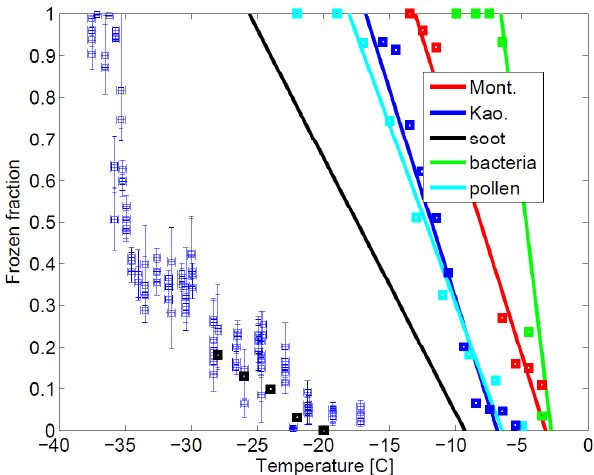
Fig. 16. Comparison of contact freezing frozen fractions obtained from wind tunnel studies (thick squares) using kaolinite (blue) and montmorillonite (red) (Pitter and Pruppacher, 1973), soot (black) (Diehl and Mitra, 1998), pollen (light blue) (Diehl et al., 2002) and bacteria (green) (Levin and Yankofsky, 1983) and CLINCH (thin squares with error bars) using kaolinite (Ladino et al., 2011b) as compared with the parameterized contact freezing frozen fractions by Diehl et al. (2006) (solid